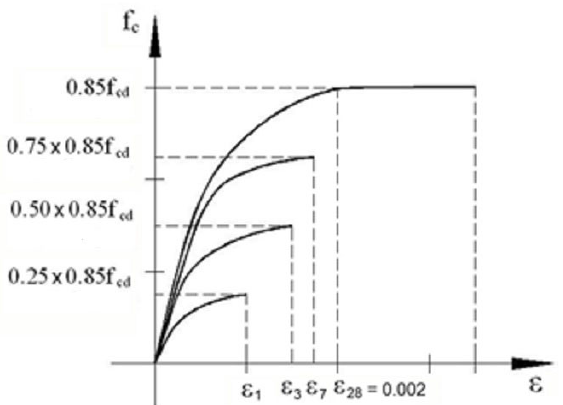
Figure 6. Stress ‐ strain relationships for different ages of shotcrete [15].